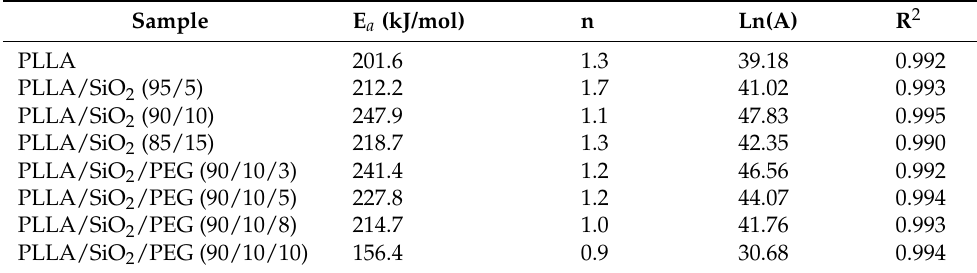
Table 9. Kinetic parameters (TGA) of PLLA, PLLA/SiO 2 , and PLLA/SiO 2 /PEG (10